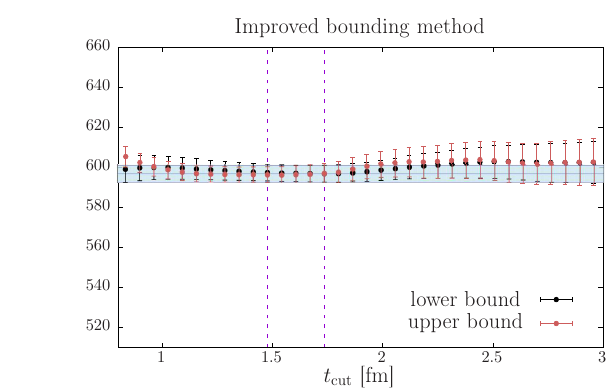
cut computed for a pion mass of